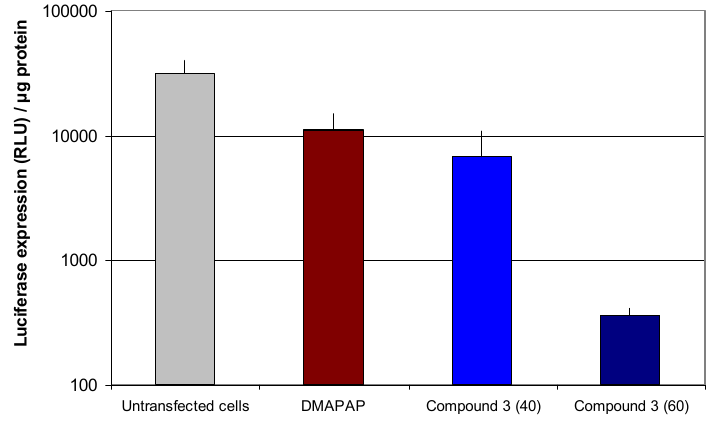
Figure 5. Efficacy of cationic and thiourea lipids to induce reduction of luciferase expression by delivering a siRNA gene silencing luciferase in B16-luciferase positive cell line . Lipid/phosphate ratios used were 40 and 60 nmol lipid/µg siRNA, with 0.15 µg siRNA. Lipoplexes were added in the cell culture medium in presence of 10% foetal calf serum and left 6 h. The medium was changed and the cells left for an additional 24 h before being lysed and processed for luciferase evaluation (for a standard protocol see reference